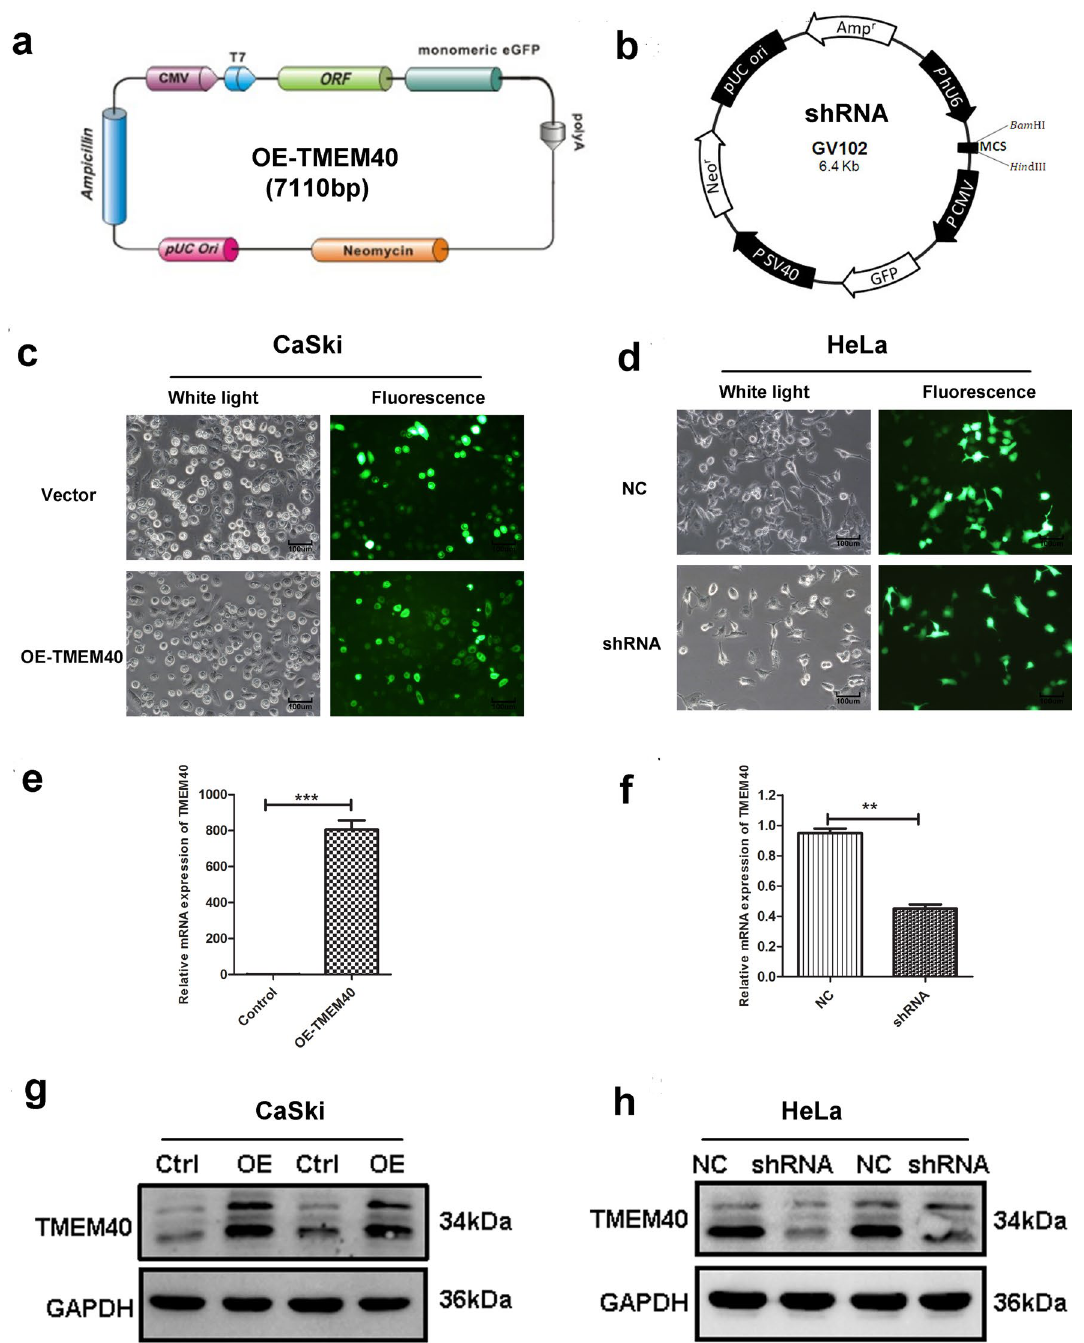
Fig. 2 OE-TMEM40 and shRNA vector construction and the expression of TMEM40. a and b , The OE-TMEM40 and TMEM40 shRNA vector was engineered to express TMEM40 under the T7 and U6 promoter. c and d , The expression of green fluorescent protein after 48 h of OE- TMEM40 and TMEM40 shRNA vector transfection in CaSki and HeLa cells (magnification × 100). e and g , The OE-TMEM40 significantly upreg- ulated the expression level of TMEM40 in CaSki cells. f and h , The TMEM40 shRNA vector significantly down-regulated the expression level of TMEM40 in HeLa cell. ** P < 0.01, *** P <